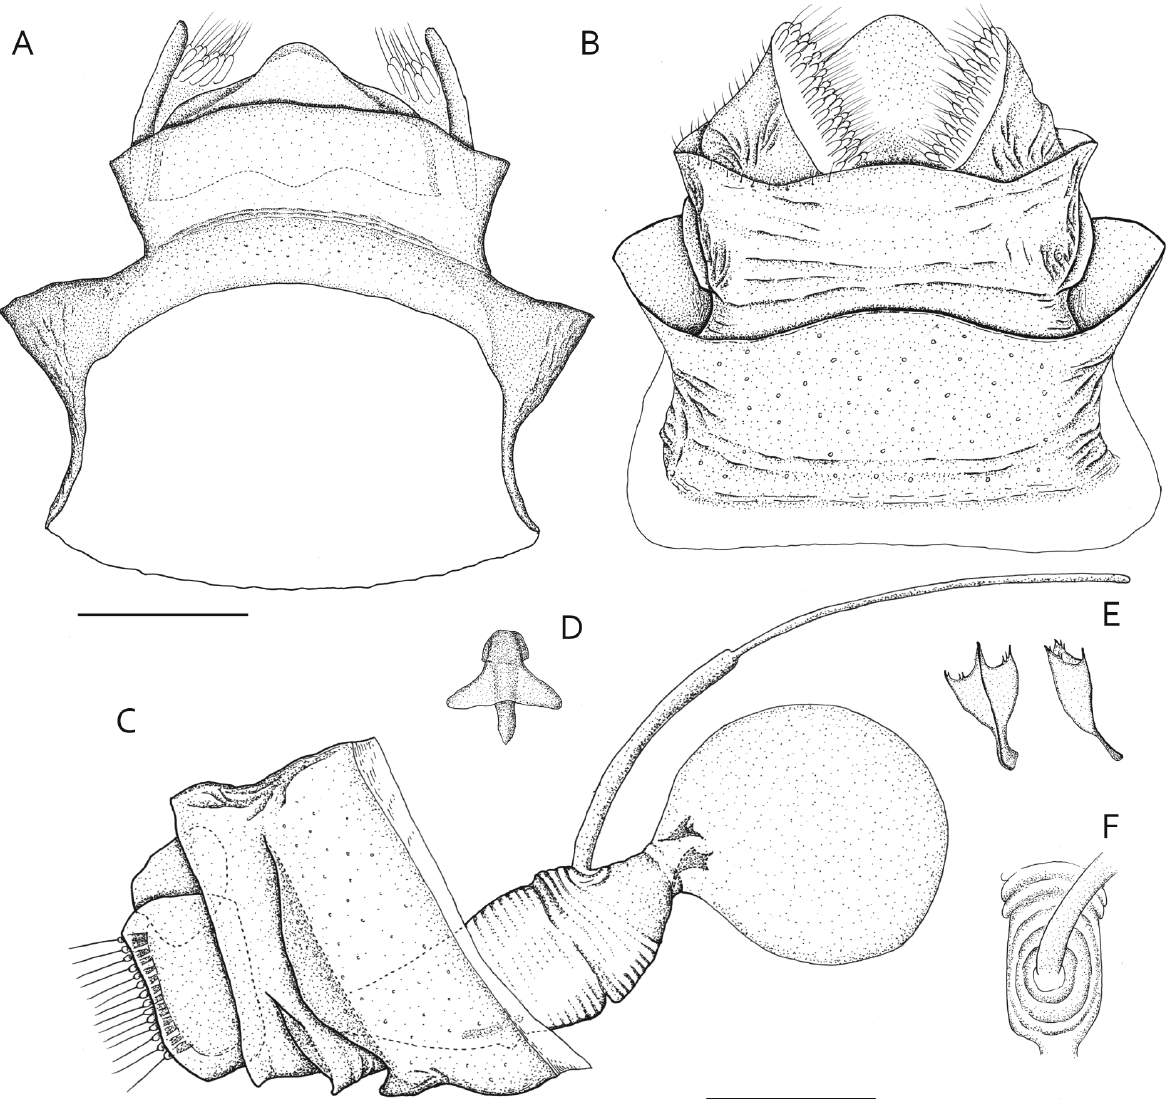
Figure 9. Female genitalia of Issikiomartyria hyperborea sp. n. [paratype]. A: genitalia capsule, dorsal view; B: ditto, ventral